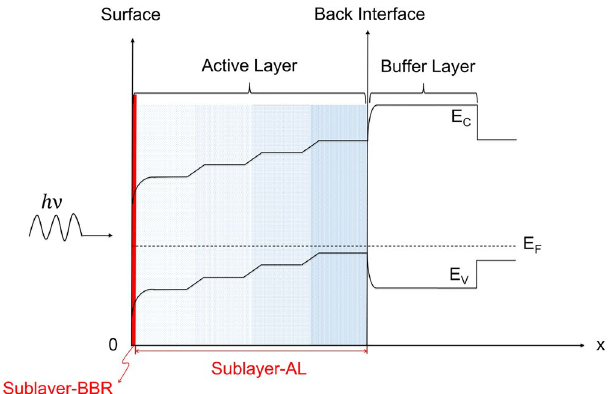
Figure 1. The band scheme of a 4-layer stepwise-doped GaAs photocathode with illustration of the two sublayers: the active layer (AL) and the band-bending region (BBR). Darker shading indicates higher doping